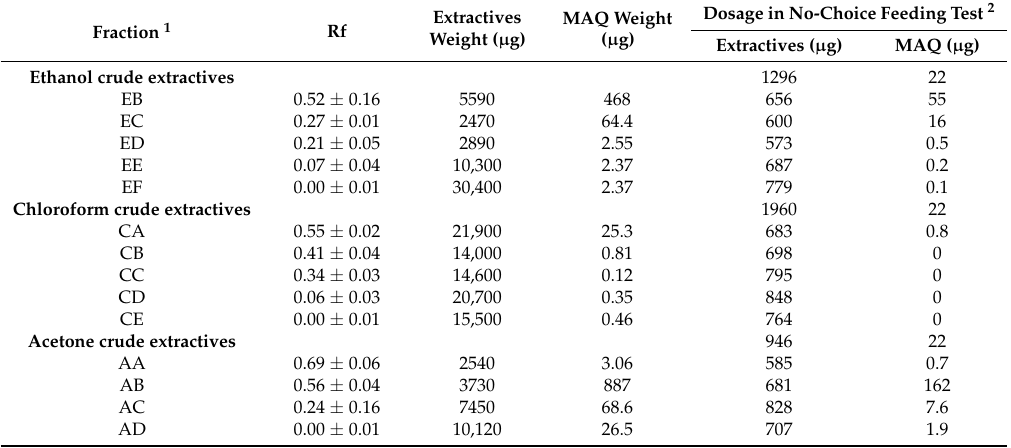
Dosage in No-Choice Feeding Test 2 Extractives MAQ Weight Weight ( µ g) ( µ g) Extractives ( µ g) MAQ ( µ g)